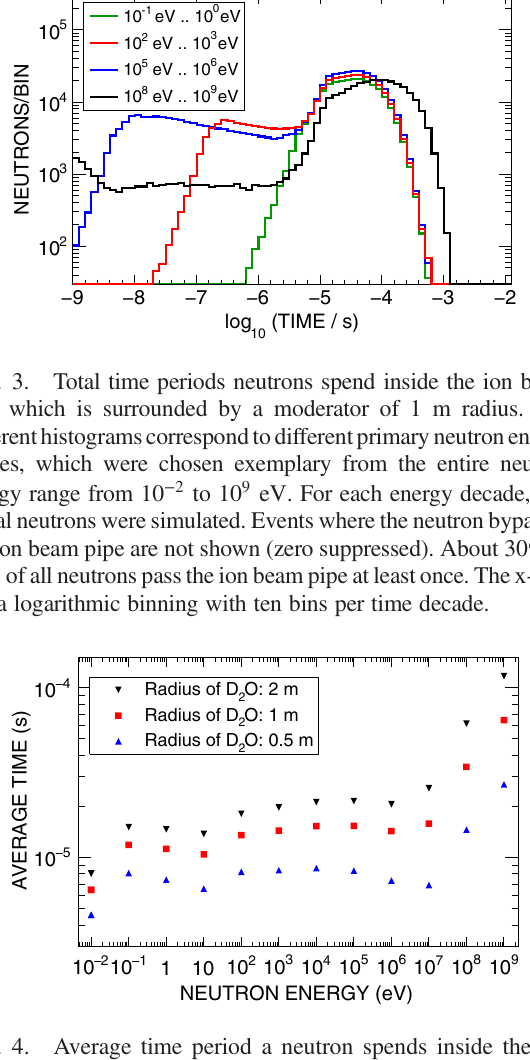
FIG. 4. Average time period a neutron spends inside the ion beam pipe for the different moderator sizes. The energy on the x-axis corresponds to the lower edge of the energy interval. Each interval corresponds to one energy decade, hence, the point at 10 8 eV corresponds to neutron energies between 10 8 and 10 9